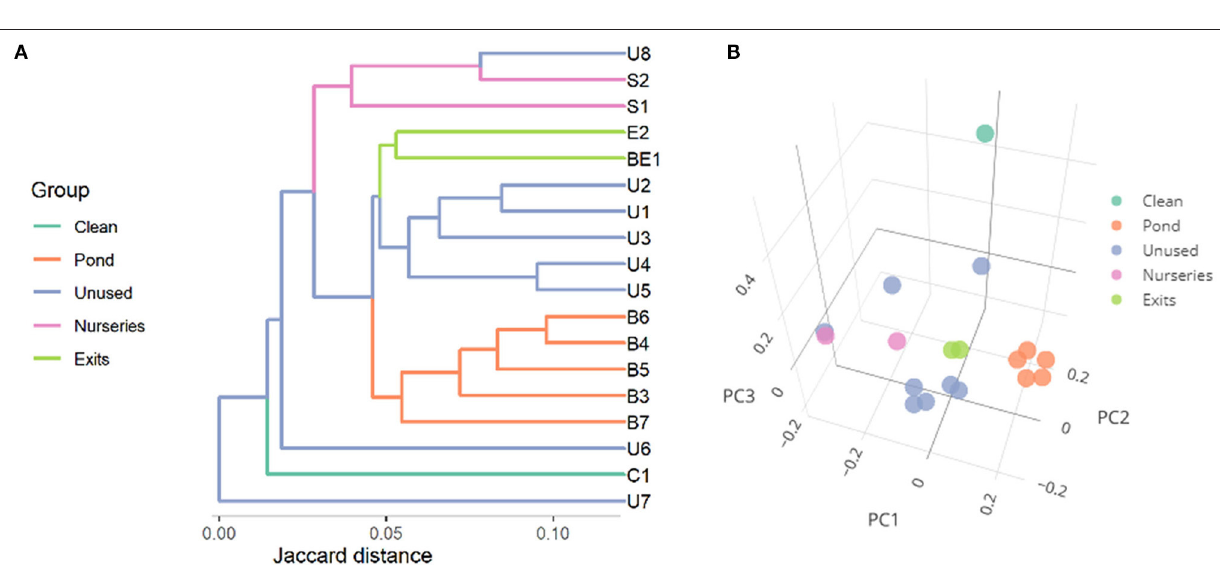
florfenicol and its metabolite florfenicol amine can be detected in surface water but not in sediments of aquaculture systems